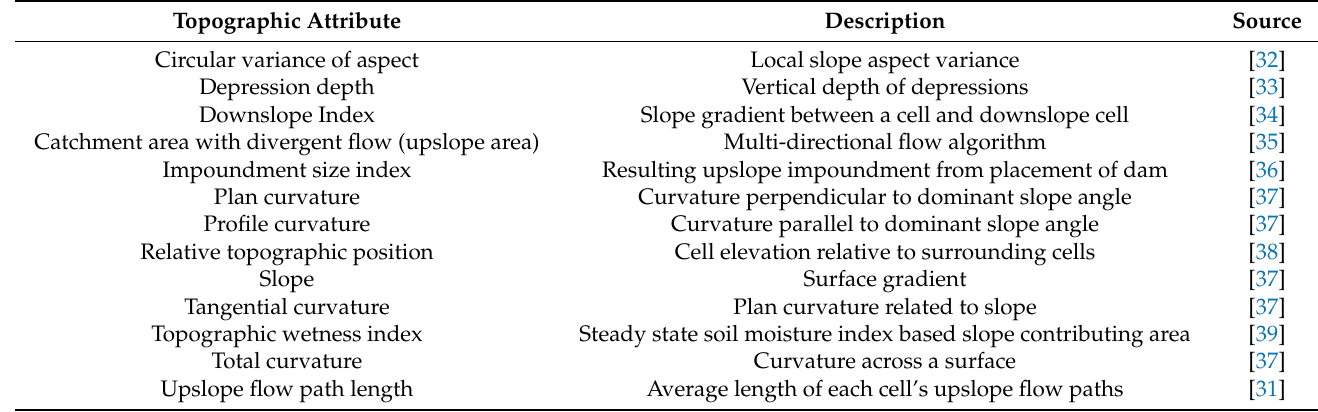
Table 2. Topographic attributes included in the regression